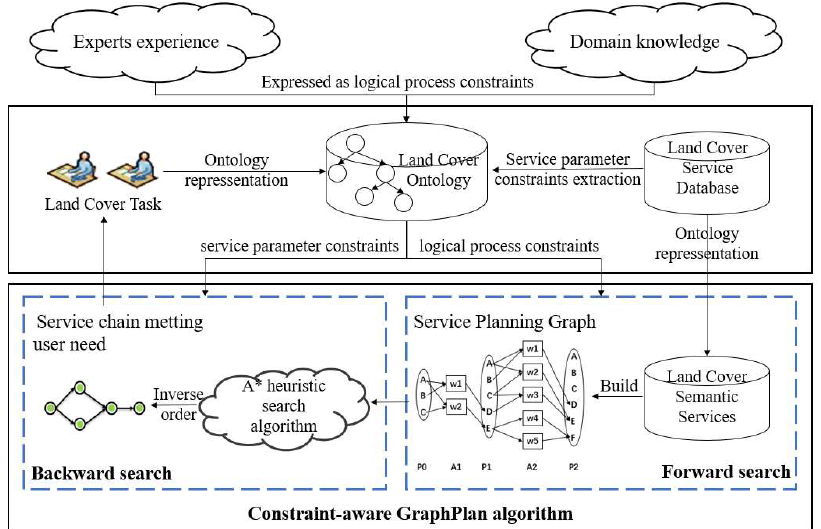
Figure 1. A methodology framework for the domain constraints-driven automatic land cover service composition approach.